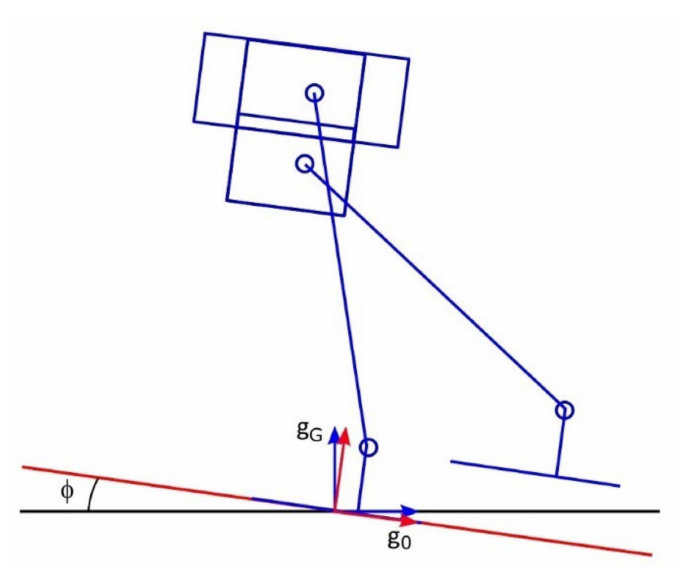
Figure 5. Tilting the plane in the walking